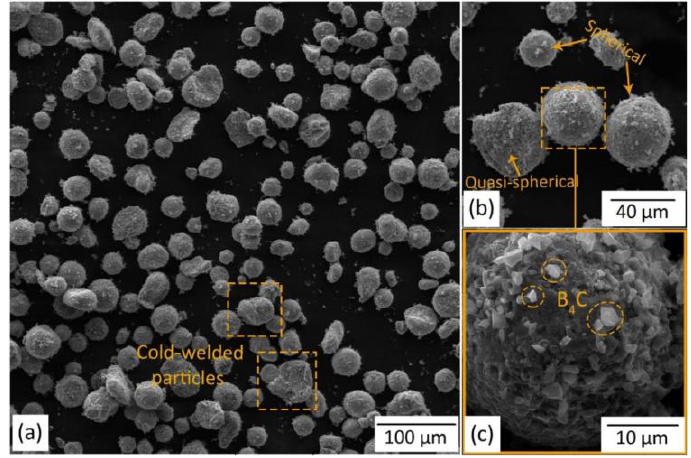
Figure 4. ( a ) SEM micrograph of the 5 wt.% B4C/Ti-6Al-4V composite powder obtained by 1.5 h of ball milling. ( b ) Higher magnification micrograph of ( a ). ( c ) Enclosed view of the selected region in ( b )